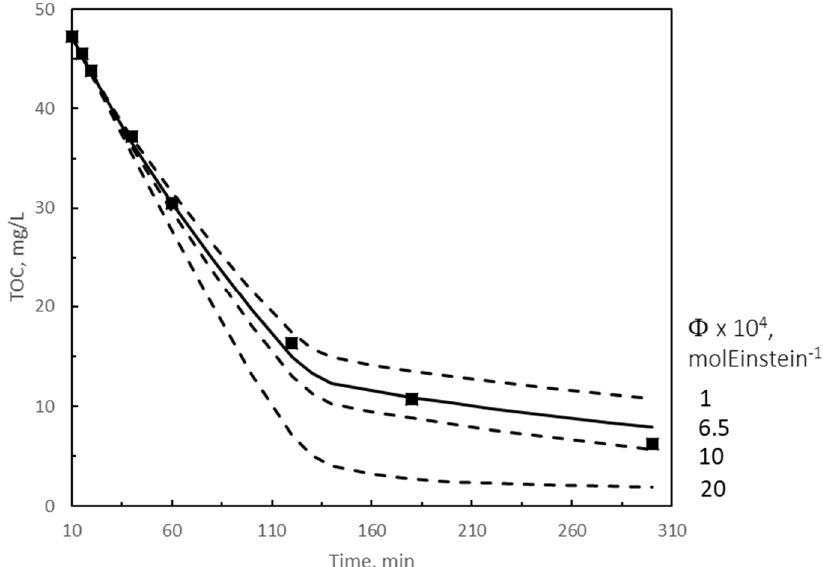
Figure 6. Solution of the kinetic model for photocatalytic ozonation. Influence of catalyst quantum yield at 425 nm. k D = 0.5 M − 1 s − 1 ; TOC 1 scavenging fraction: α = 0.1 for first 120 min, variable (following an exponential function) between 0.1 at 120 min and 0.9 at 150 min reaction, then constant at 0.9. Symbols: experimental results. Continuous and dotted curves: calculated results. Continuous curve: best fitting results. Other experimental conditions as in Figure 2. Experimental TOC values from [30].